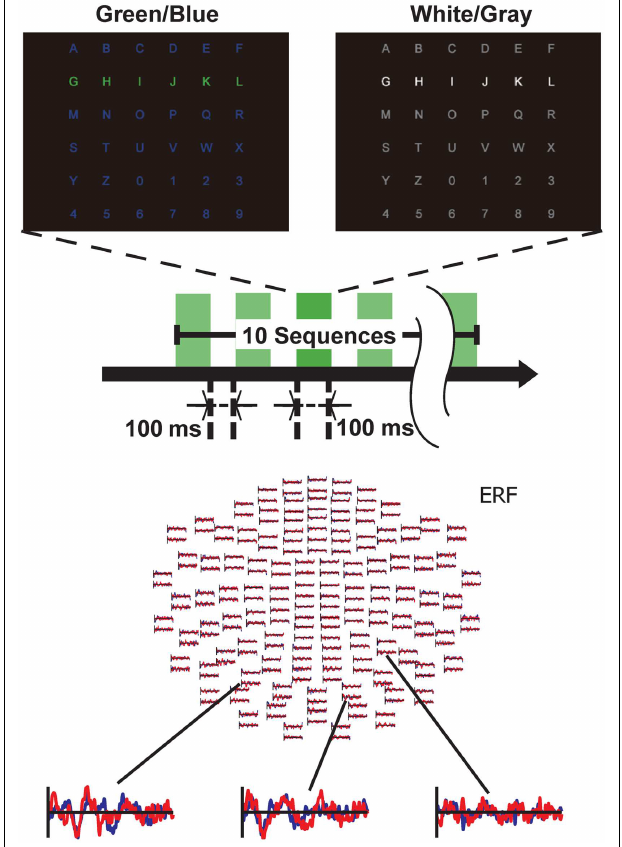
FIGURE 1 | Experimental setting .Two types of matrices were used: one for the green/blue (GB) condition and the other for the white/gray (WG) condition. Stimuli were presented in chromatic (GB) and luminance (WG) flickering patterns. Subjects were required to gaze at and attend to the target letter. Event-related fields from a representative subject under the GB condition are shown.The red lines indicate the averaged ERF elicited by the non-target stimuli, whereas the blue lines show the averaged ERF elicited by the target